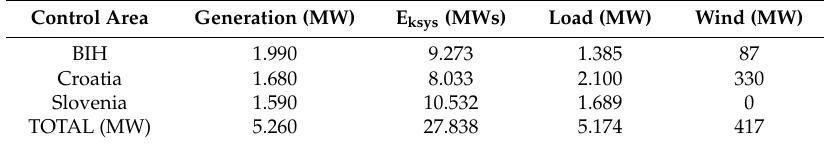
Table 4. ENTSO-E Slovenia, Croatia and BIH (SCB) control block electric power system (EPS) data.